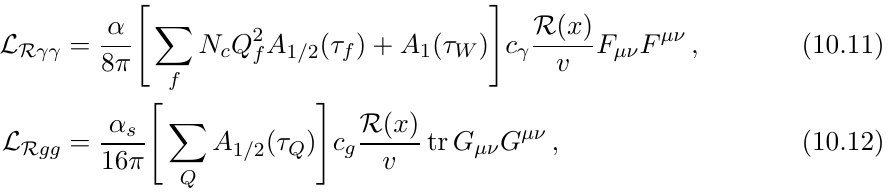
Table 3 . Masses of the radion and the n = 1 graviton mode, and coupling coe(cid:14)cients of the radion interactions with the SM (cid:12)elds, for the scenario B 2 , B 8 , C 1 , C 2 , D 1 and E 1 . and similarly for gluons. For our aim it is convenient to re-express such Lagrangians in terms of the canonically normalized radion R . We